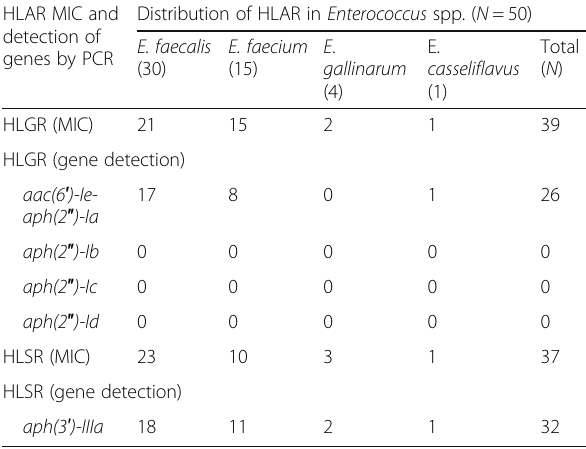
Table 3 Distribution of aminoglycoside modifying enzyme- encoding genes among Enterococcus species with high-level aminoglycoside resistance HLAR MIC and Distribution of HLAR in Enterococcus spp. ( N = detection of